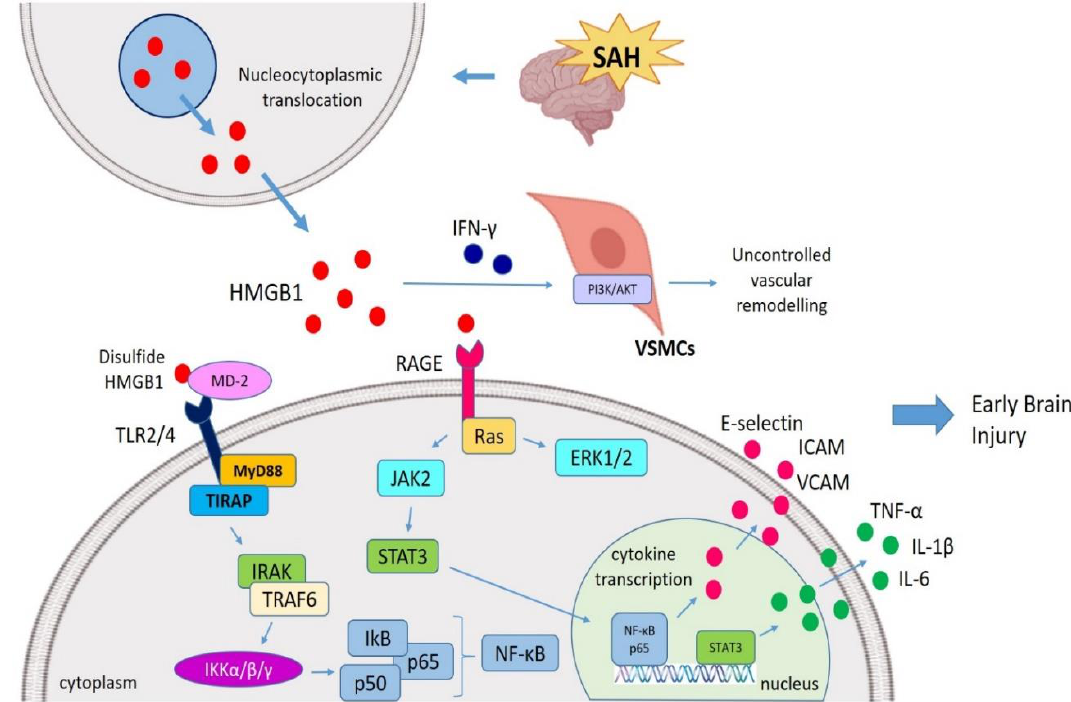
Figure 2. HMGB1-mediated EBI post-SAH. During SAH, after a HMGB1 translocation from nucleus to cytosol, extracellular HMGB1 interacts with TLR4 (via MD-2) and RAGE (via Ras) and initiates the MyD88 and JAK pathways. HMGB1 is also able to stimulate ERK1 / ERK2 pathways. HMGB1 drives an inflammatory cascade via the JAK-STAT signaling pathway following SAH which ultimately resulted in the translocation of NF- κ B p-65 to the nucleus to activate transcription of pro-inflammatory genes (IL-1 β and TNF- α ). In addition, HMGB1 also amplifies the secretion of VCAM, ICAM and E-selectin. In this regard, HMGB1 mediate the early brain injury (EBI) followed SAH as well as vascular remodeling post-SAH (mainly by triggering VSMCs via IFN- γ interaction). SAH, Subarachnoid hemorrhage; HMGB1, High mobility group box 1; TLR4, Toll-like receptor 4; RAGE, Receptor for advanced glycation end products; MD-2, Myeloid differentiation factor-2; MyD88, Myeloid differentiation response protein 88; ERK, Extracellular signal-related kinase; JAK, Janus